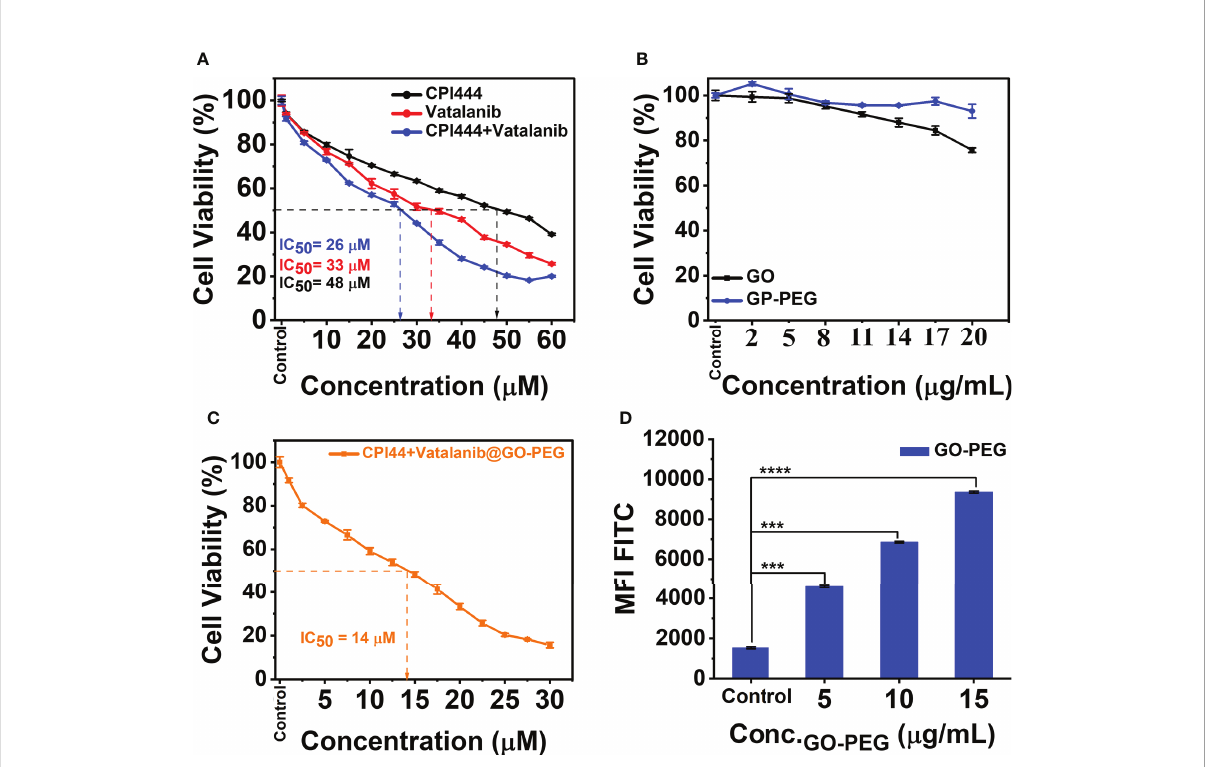
FIGURE 6 Cell viability studies and cellular uptake of PEGylated graphene oxide. (A) CPI444 and vatalanib cell cytotoxicity were calculated in GBM U87 cells. Cells were treated with drugs individually along with different concentrations for 48 h. After 48 h, IC 50 values were calculated. (B) Cytotoxicity analyses of GO and GO-PEG were performed in GBM U87 cells. The PEGylated graphene oxide carrier did not show signi fi cant cytotoxicity in the GBM cell line up to 20 µg/ml. (C) In the GBM U87 cell line IC 50 value of CPI444 + vatalanib@GO-PEG is ~14 µM. (D) To con fi rm the cellular internalization of PEGylated GO nanoparticles in the GBM cells, we conducted a FACS study after 24 h of incubation with different concentrations of PEGylated graphene oxide nanoparticles; MFI (Mean Fluorescence Intensity) in arbitrary units (AU); **** p < 0.0001 and *** p <